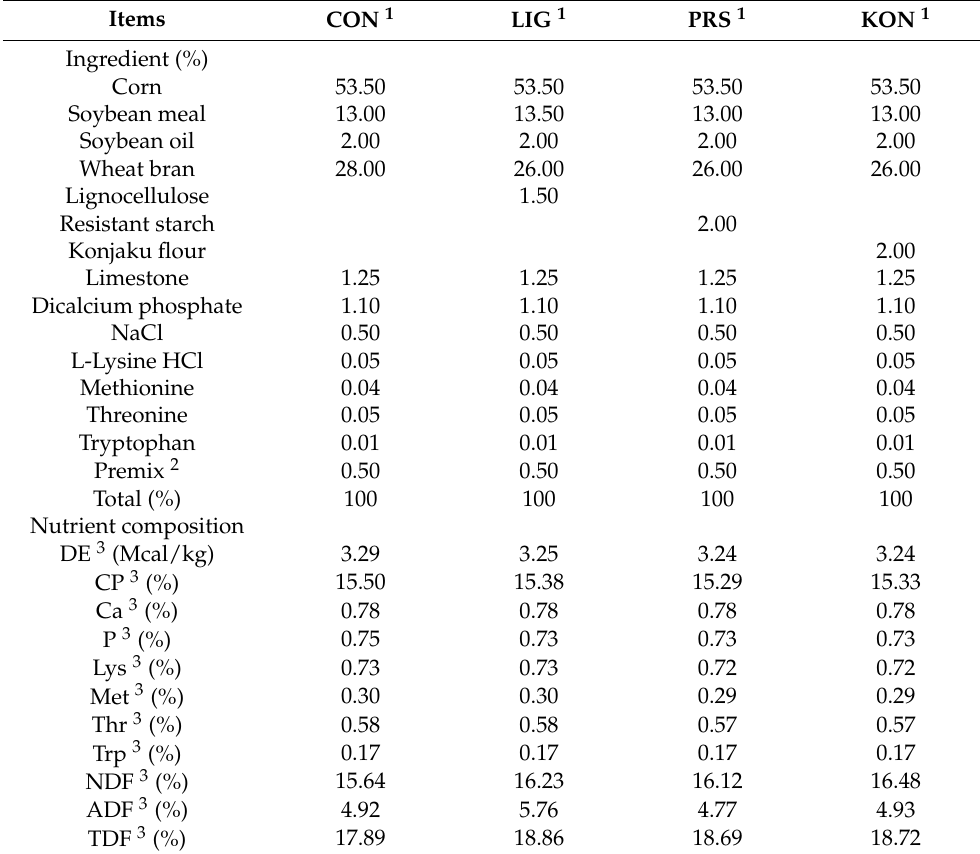
Table 1. Ingredients and nutrient composition of the experimental diets (%, as-fed